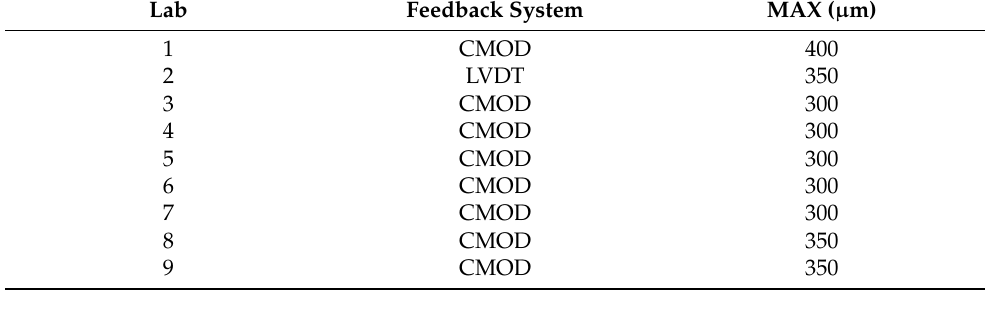
Table 3. Closed-loop feedback system used by the different labs and ultimate crack width during loading W after which specimens were unloaded.